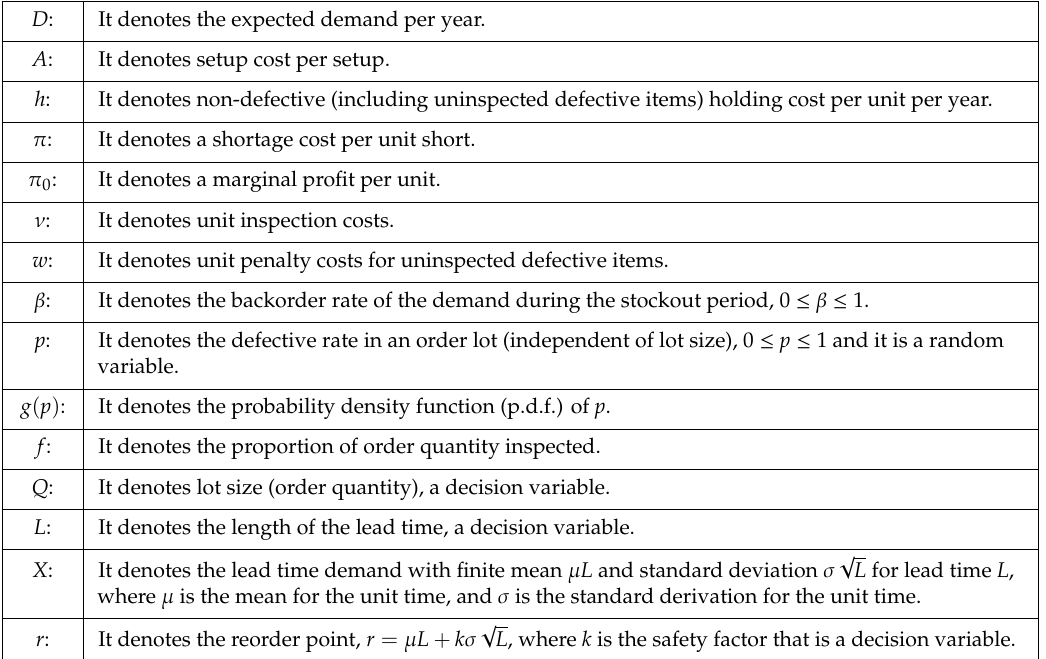
EOQ Numerical Analytical Model Approach